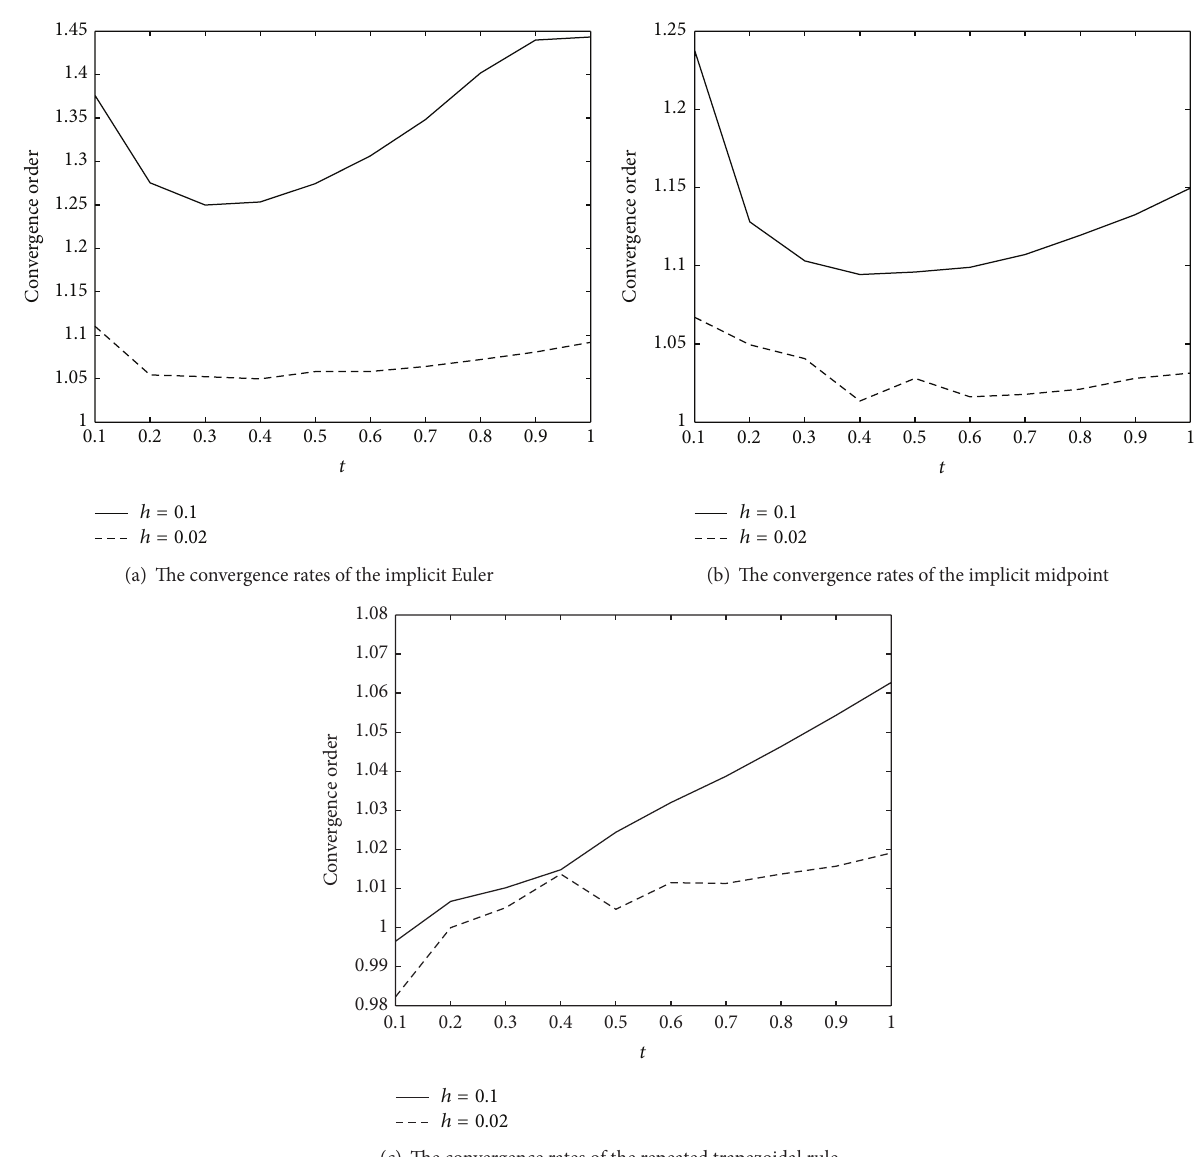
(c) The convergence rates of the repeated trapezoidal rule Figure 1: The convergence rates for